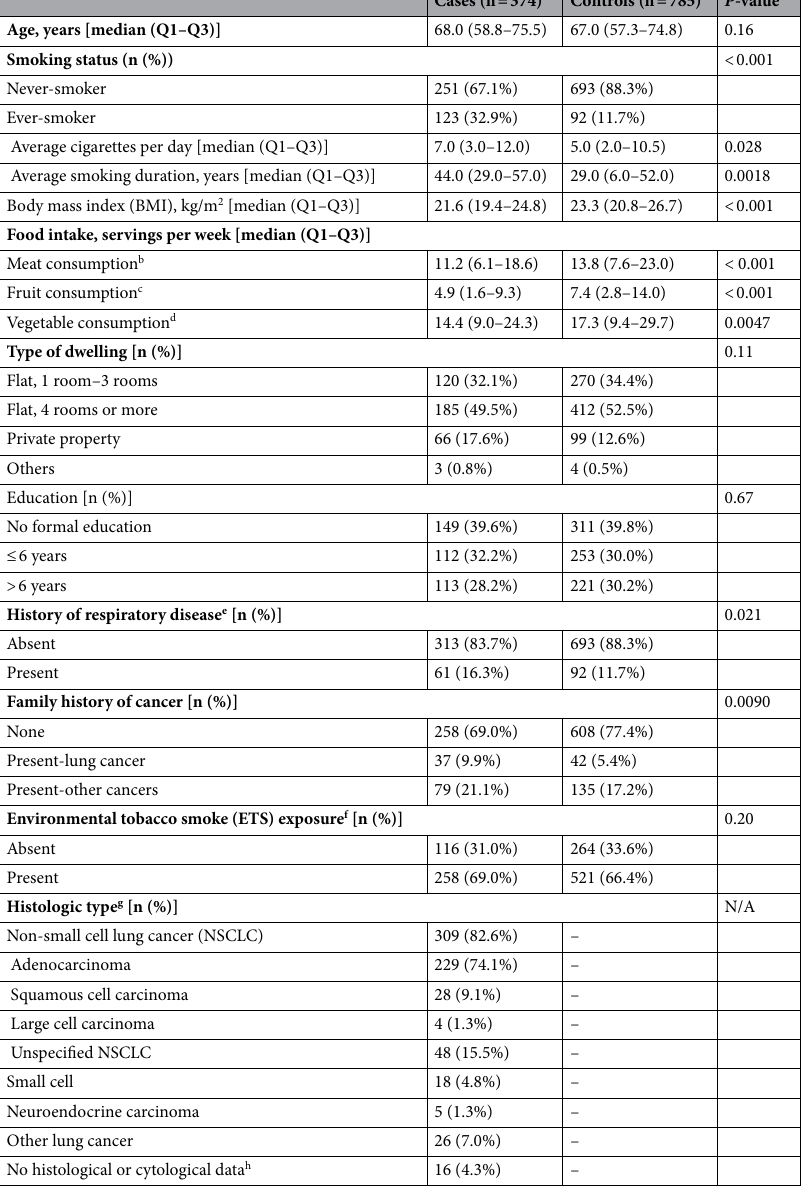
Table 1. Baseline characteristics of the study population (Chinese females). a P-values were obtained using Fisher’s exact test for categorical variables and Mann–Whitney U test for continuous variables. b Fish, chicken, pork, duck, prawns, squid and beef. c Bananas, papayas, apples, oranges, pineapples, watermelons, mangoes, starfruit, jackfruit, plum, cantaloupe, dried prunes, fresh fruit juice and canned peaches. d Wong-nga-pak (Chinese napa cabbage), pak choy (Chinese cabbage), kai lan (Chinese kale), head cabbage, cauliflower, kai choy (Chinse mustard), choy sum (Chinese flowering cabbage), kang kong (water convolvulus), sai yong choy (watercress), por choy (spinach), sang choy (Chinese lettuce), tomatoes, broccoli, French beans, string (long) beans, snow peas, ladies’ fingers, carrot (red) and sweet potato. e Tuberculosis, childhood pneumonia, asthma, chronic bronchitis or emphysema. f ETS exposure is defined as ETS exposure at home more than once per week and/or ETS exposure at work. g Classification based on ICD-O-3 codes detailed in Supplementary Table 1, unless otherwise specified. h Diagnosis of primary lung cancer in these subjects were based on radiological examination and after ruling out of the possibility of malignancy from another primary